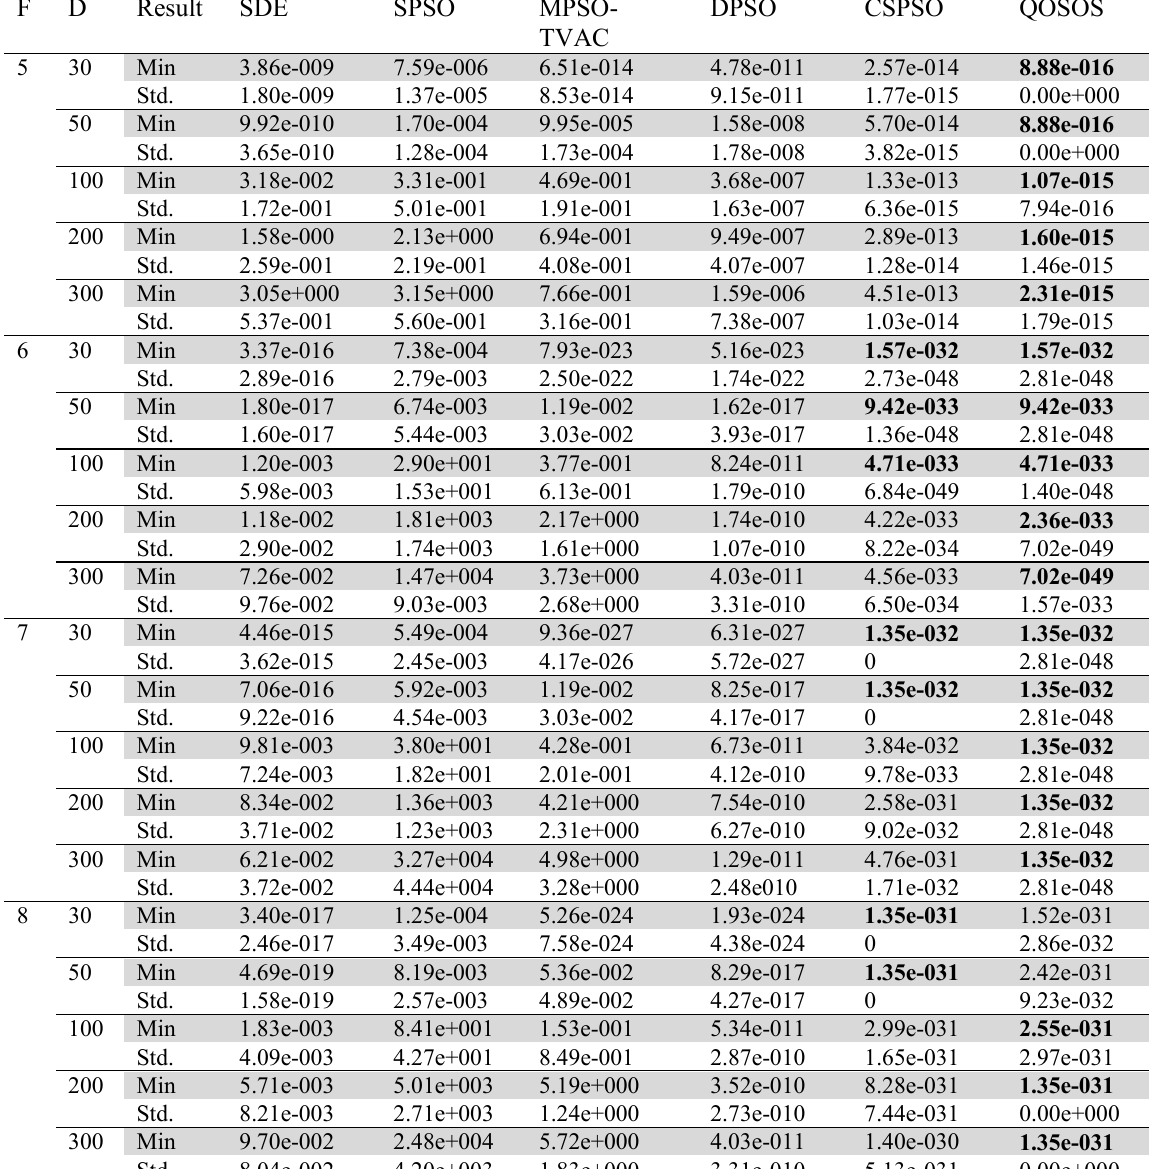
Performance results of SDE, SPSO, MPSO-TVAC, DPSO, CSPSO and QOSOS at dimensions (D) 30, 50, 100, 200 and 300 after reaching D*5000 FEs of four (F5-F8) well known benchmark functions over 20 runs with 40 eco-size. ‘‘Min ’’ and ‘‘std.’’ show the best and standard deviation of the benchmark functions respectively. Boldface represents the best result among the compared